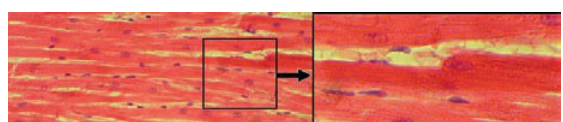
Figure 3. Light microscopic examination of the myocardium of defibrillated dogs. No acute histo-pathological change typical of tissue injury was detected in the defibrillated dogs [Right panel is the magnified view of the left panel].